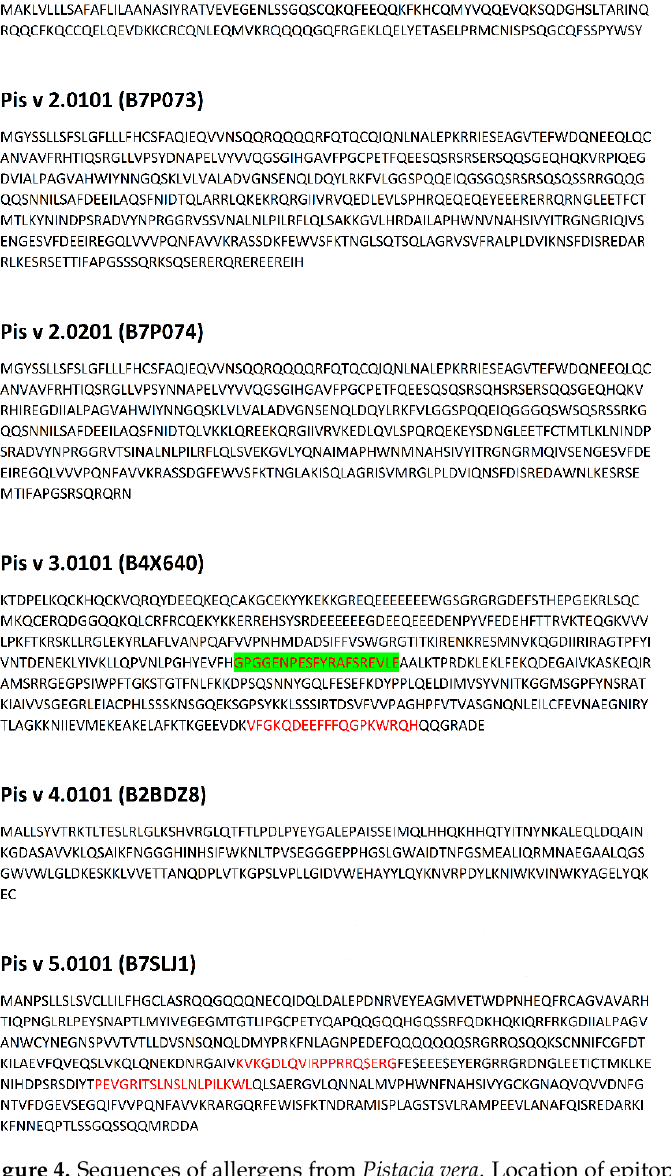
Figure 4. Sequences of allergens from Pistacia vera . Location of epitopes is indicated using red font. Green background indicates epitopes with highest ∑ A (range 1.6000–2.1000).